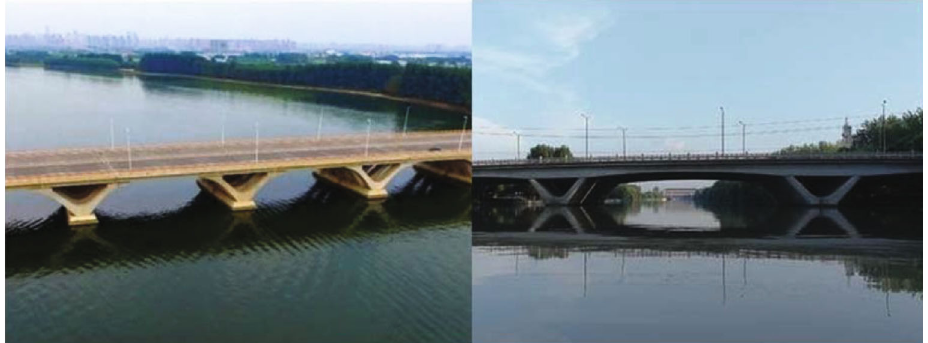
Figure 4: V-shaped